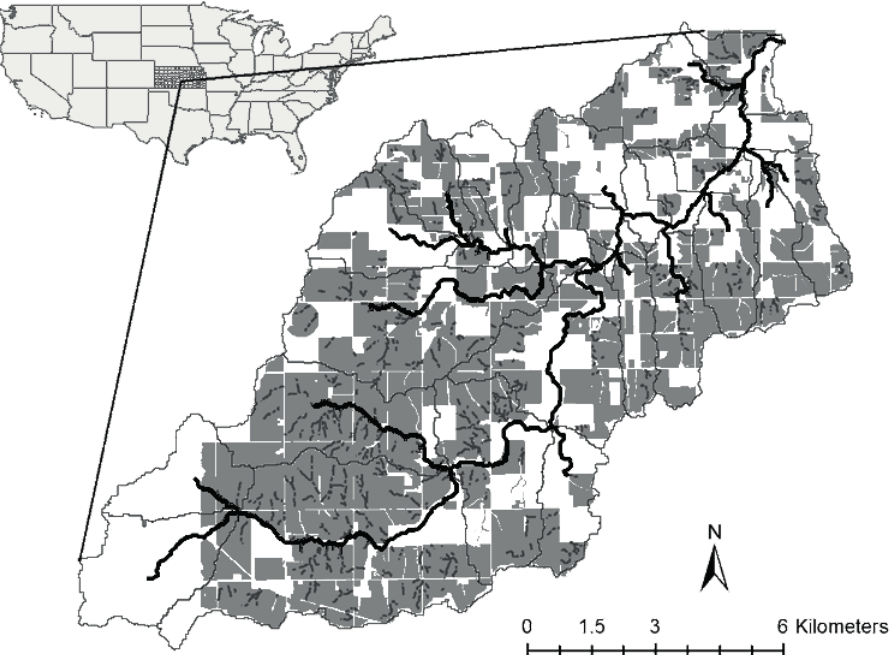
Fig. 1 Map of Goose Creek watershed in central Kansas, USA, showing cultivated cropland fields (dark areas), ephemeral gullies (short solid lines), stream network (black lines), and